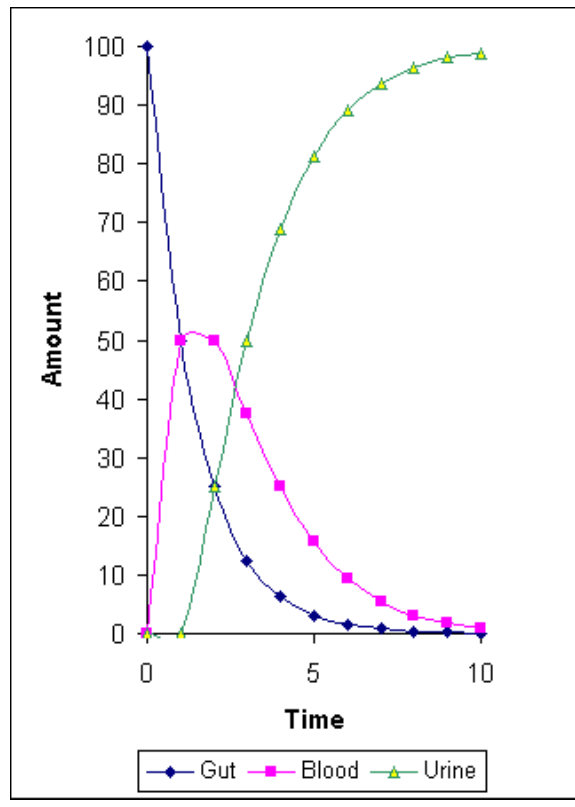
FIGURE 2 . Simulated curves for absorption of drug from gut into blood and elimination into urine.